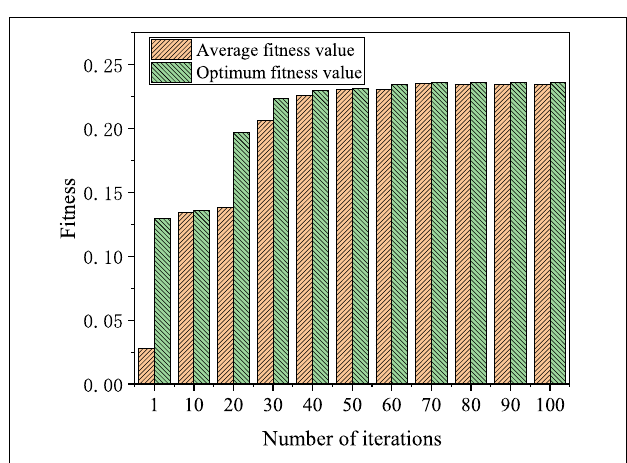
FIGURE 16 | GA-BPNN fitness results.